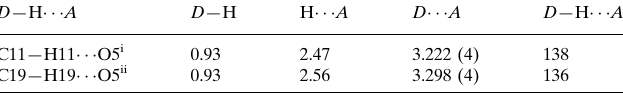
Hydrogen-bond geometry (A˚ , (cid:1)